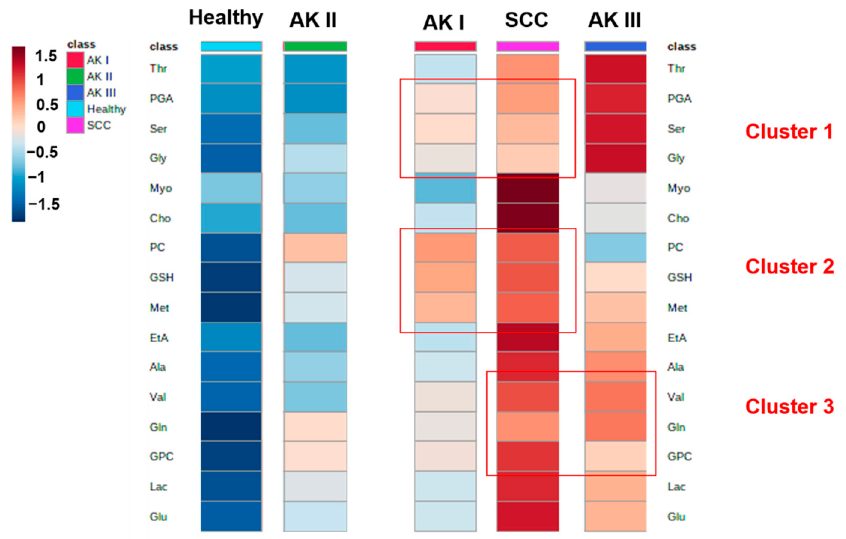
Figure 5. Cluster heat map with all 5 classes are reported. Three major metabolites clusters are identified: Cluster 1: PGA, Ser and Gly; Cluster 2: PC, GSH and Met; and Cluster 3: Val, Gln and GPC.